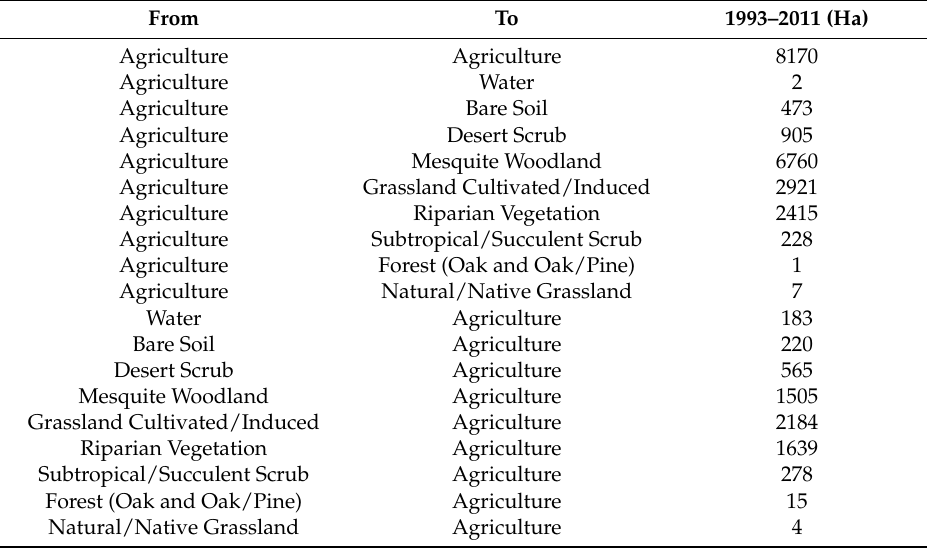
Land cover trends relative to the Agriculture class along the 5 km buffer in both